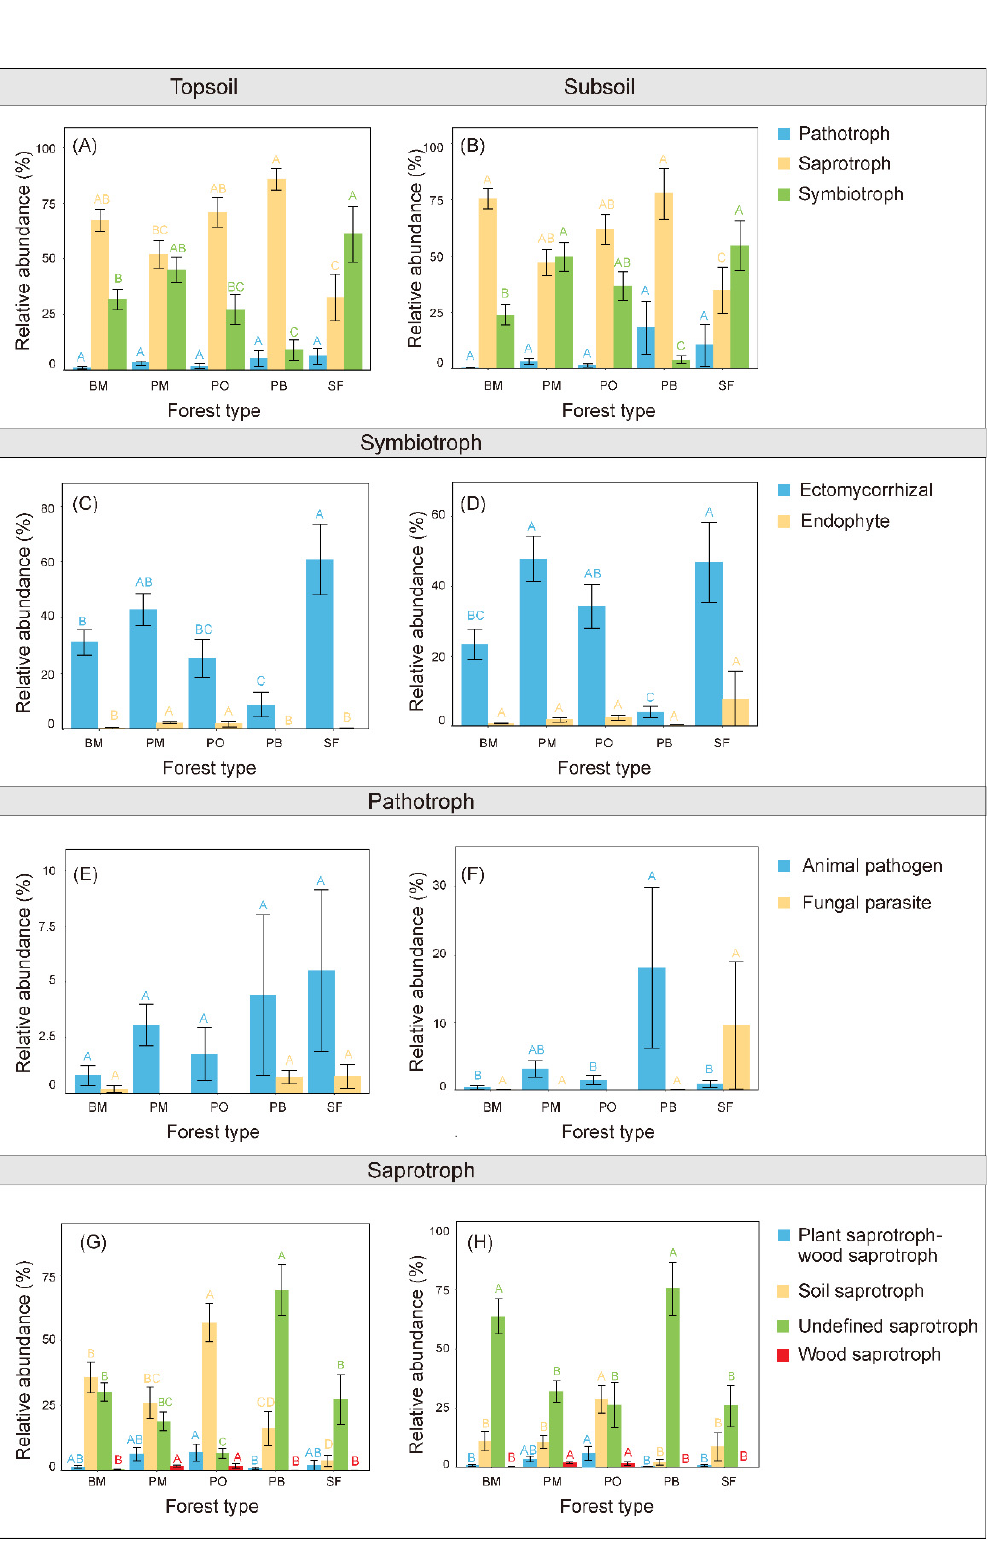
Figure 5. Relative abundance of fungal guilds among different forest types. ( A , C , E , G ) topsoil; ( B , D , F , H ) subsoil; Significant differences ( p < 0.05) in different forest types are indicated by letters in different colours. Broadleaf-oriented transformation, BM; P. massoniana mature plantation, PM; P. massoniana overmature plantation, PO; P. massoniana + local broadleaved trees, PB; secondary forests, SF.